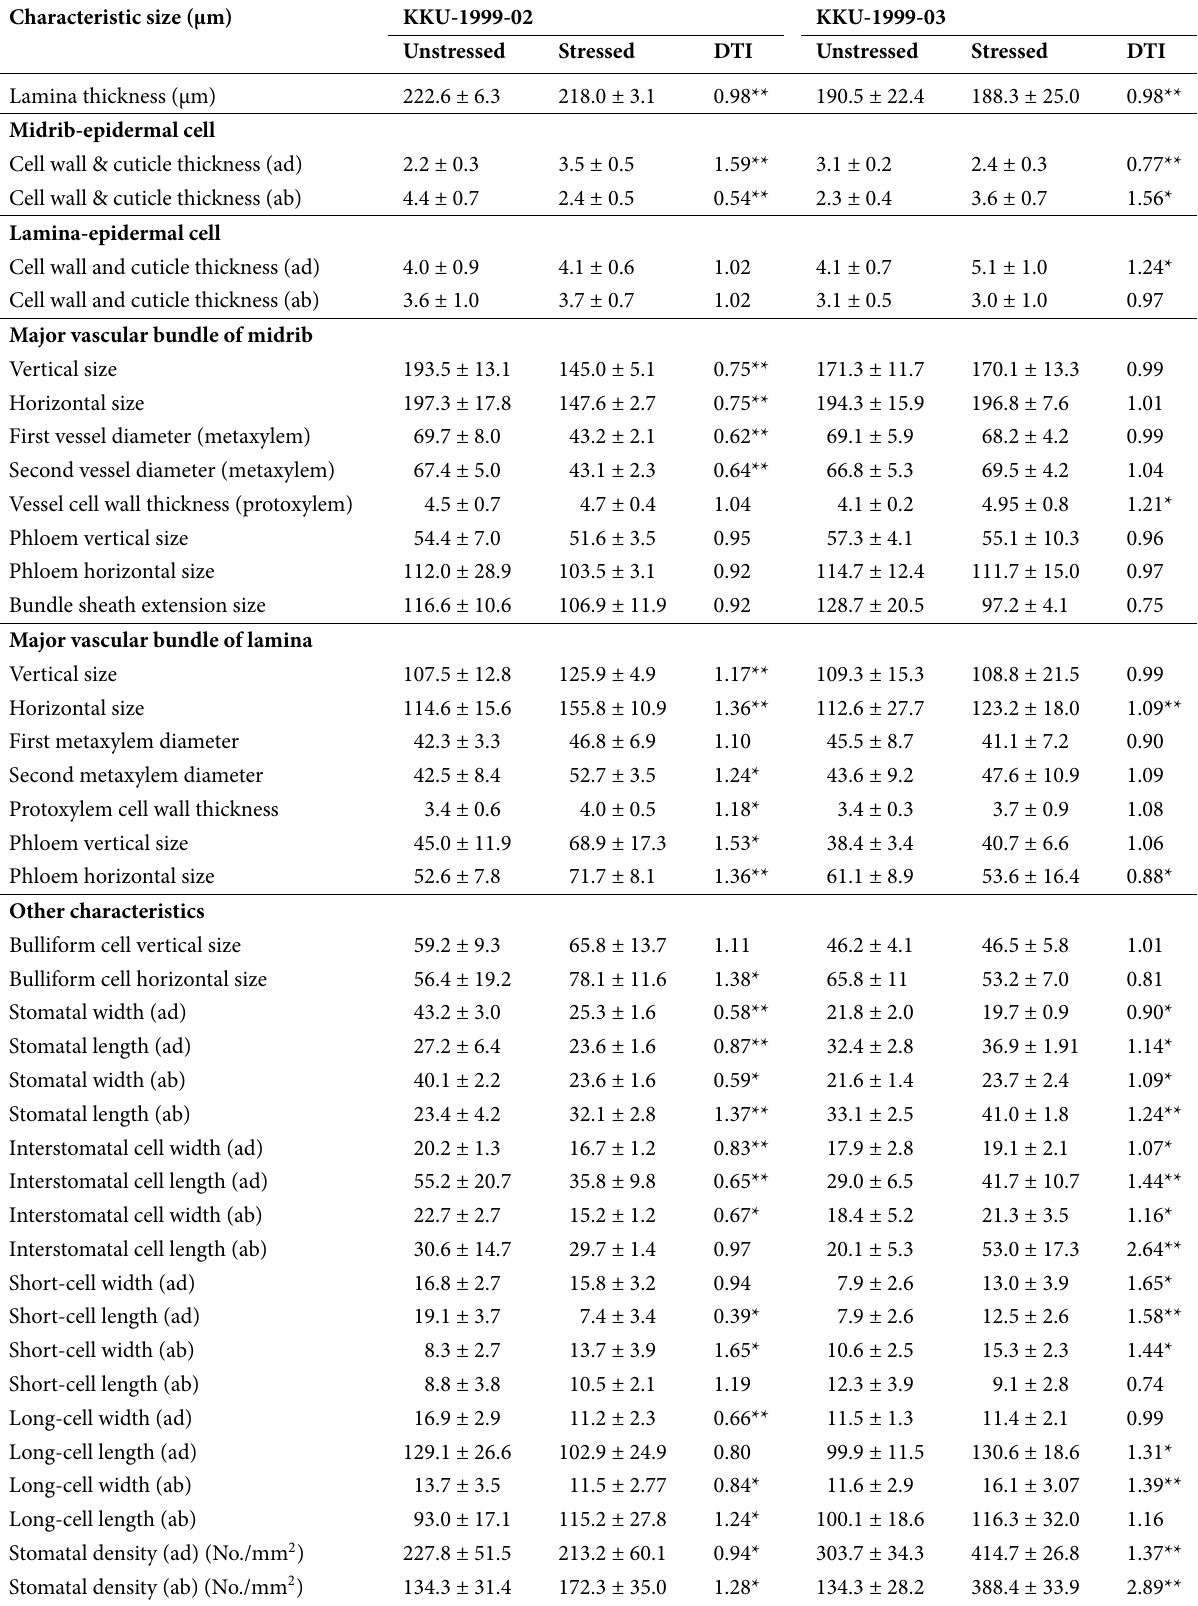
Table 1 Forty anatomical characteristics of Saccharum KKU-1999-02 and KKU-1999-03 under drought stress or field capacity (control)